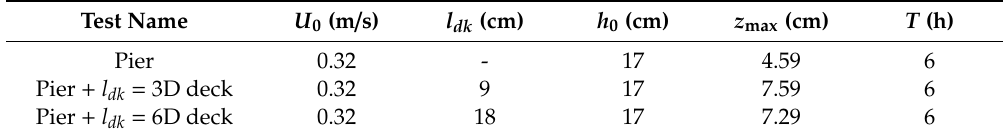
Table 1. Experimental